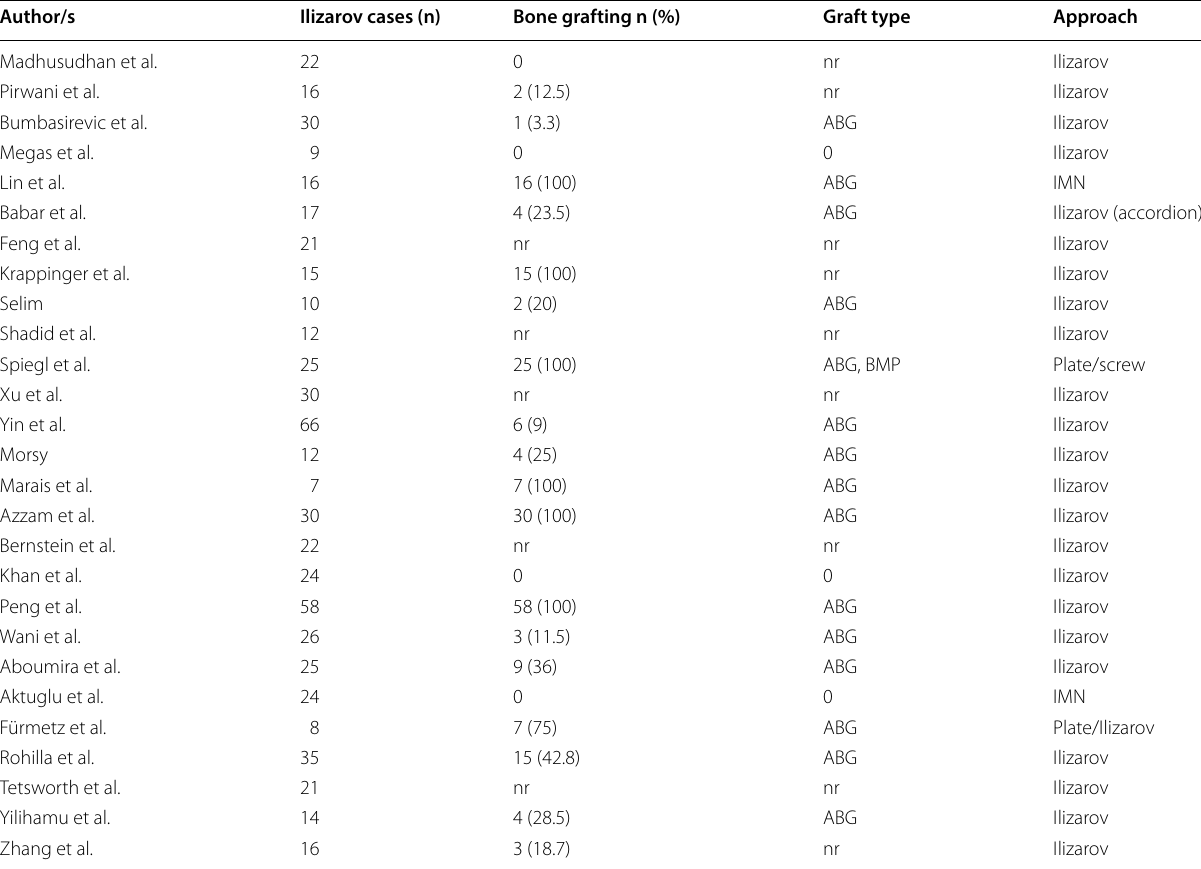
Table 6 Details of bone healing problems of docking